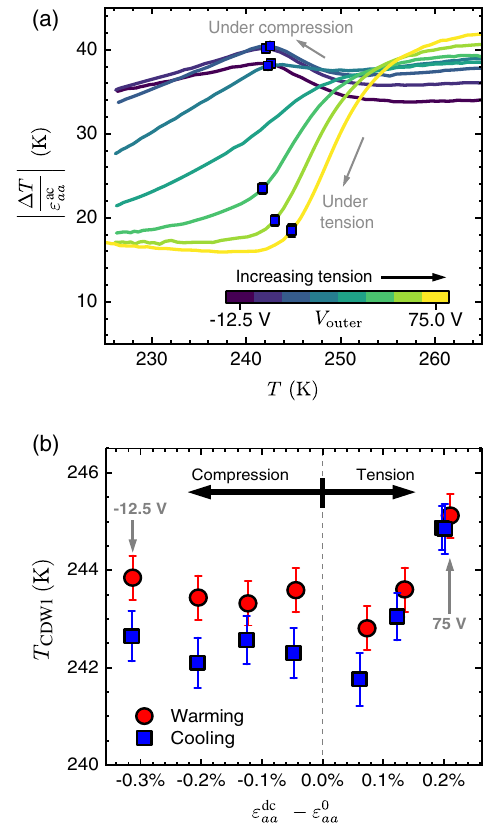
FIG. 4. Elastocaloric effect measurements in TmTe 3 with stress parallel to the a axis. (a) Magnitude of the elastocaloric response near T as a function of temperature and PZT voltage. Each CDW 1 trace was collected by cooling at a constant V , and T is outer CDW 1 extracted by the second derivative. Despite using different data acquisition protocols and different rare earths, the results in Fig. 3 share the same behavior. (b) Extracted critical temperatures on the same sample for both warming and cooling traces. The increase of T for tensile strains is clearly defined, although an CDW 1 increase on the compressive side is not observed. We attribute this to slight buckling of the sample, resulting in an overestimate of the compressive strain. One of the curves near the center exhibited no clear extremum in the second derivative, so T CDW 1 could not be unequivocally identified. Tension and compression ¼ 0 are labeled (black arrows) relative to ˜ ε A